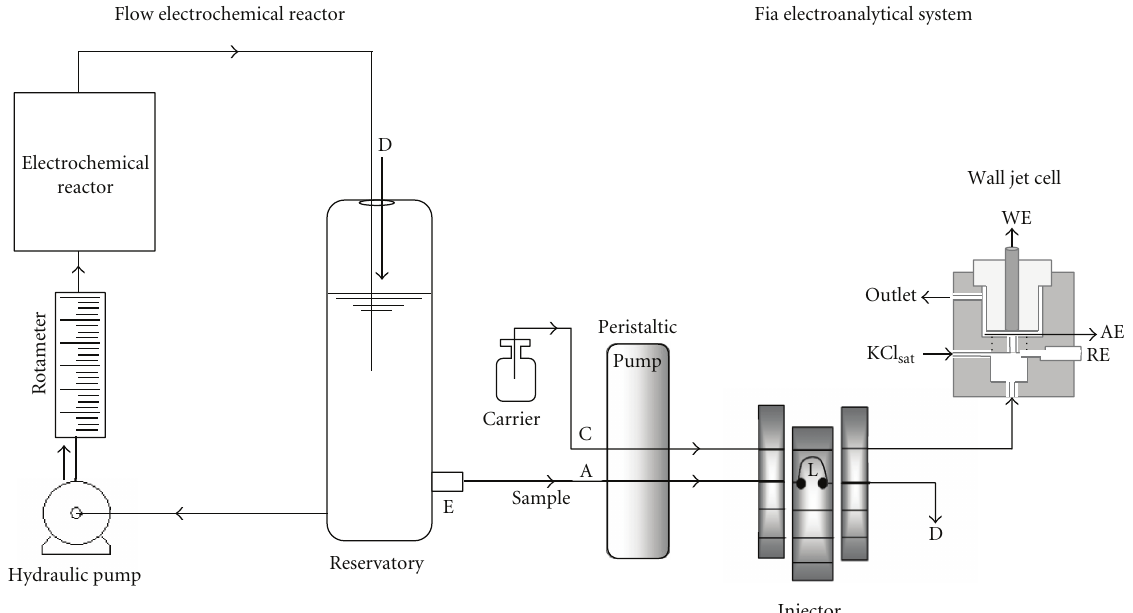
Figure 2: Scheme of the coupling of the reactor with the FIA system. WE is the biomimetic sensor, AE represents the counter electrode, RE is the reference electrode. The D channel is used for the return of the electrolysis solution (sample) from the injector to the reservoir of the reactor, allowing maintain-sink condition in the experiments without loss of volume and thus avoiding errors in the calculation of the concentration of paracetamol, since the injected volume is only 75 μ L in each sampling.